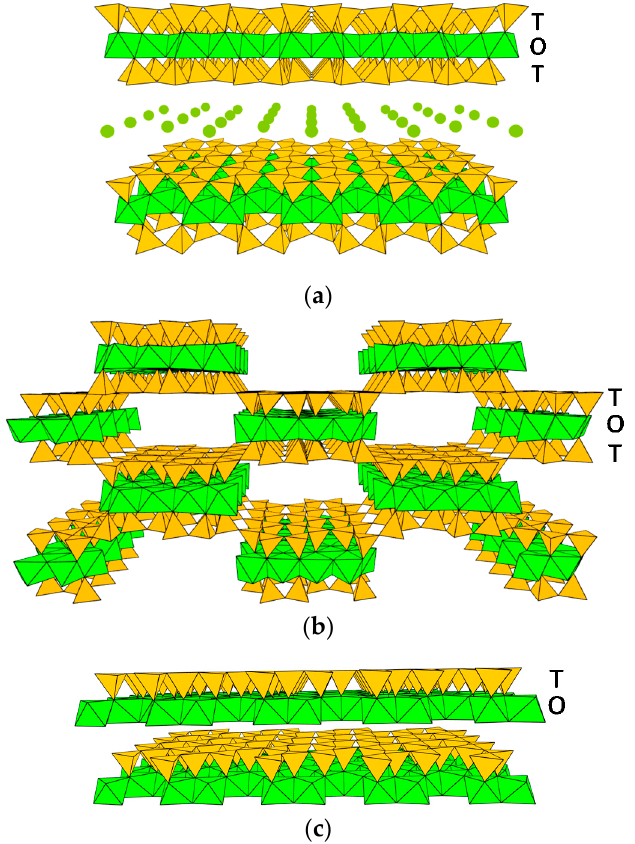
Figure 1. Structures of selected phyllosilicates: ( a ) montmorillonite; ( b ) sepiolite; ( c ) kaolinite; TOT or TO sheet arrangements are indicated.